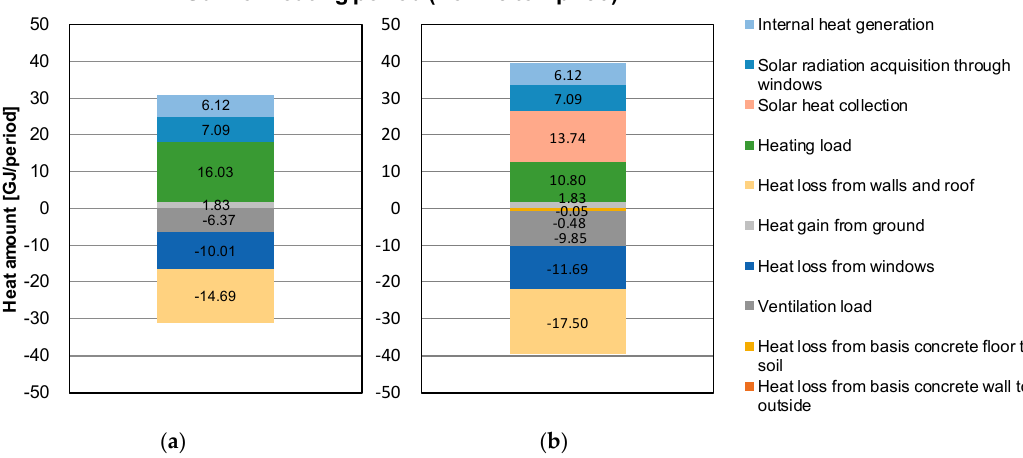
Figure 16. Heat balance of heat supply and heat loss in winter: ( a ) typical house (non-heat collection); ( b ) house with an air-based solar system.